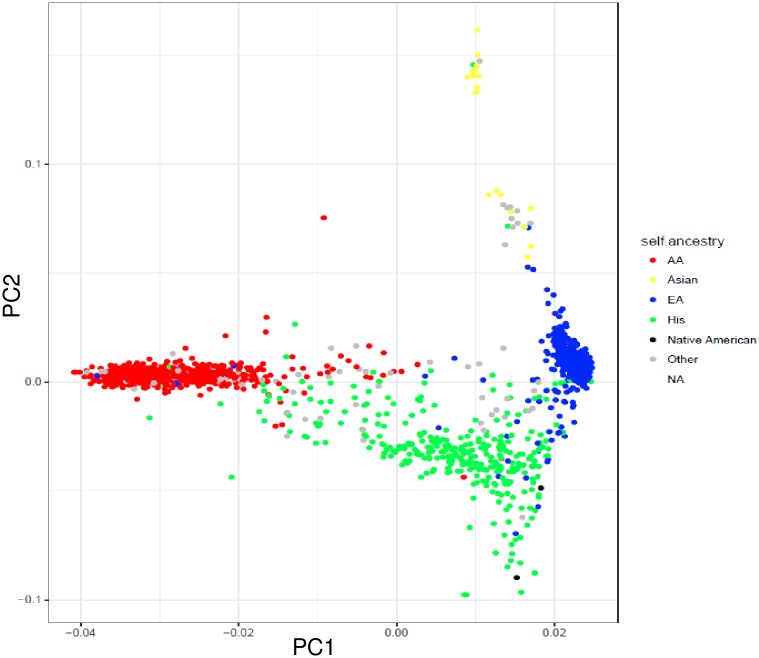
Scatter plot of the two main principal components based on filtered genome-wide genotype data of the original cohort.Each dot represents one individual colored by self-described ancestry. Color code: red: Africans; yellow: Asians; blue: Europeans; green: Hispanics; black: Native Americans; and gray: ‘others’. The corners correspond to high proportions of European, African, Asian and Native American ancestry.